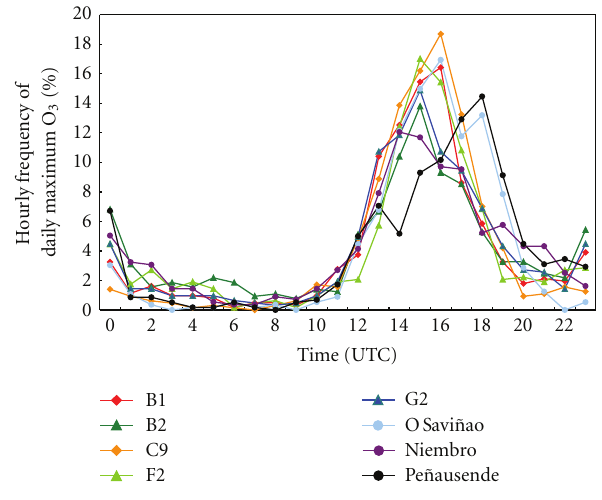
Figure 12: Frequency distribution of daily maximum hourly ozone in summertime (June–August) during the period